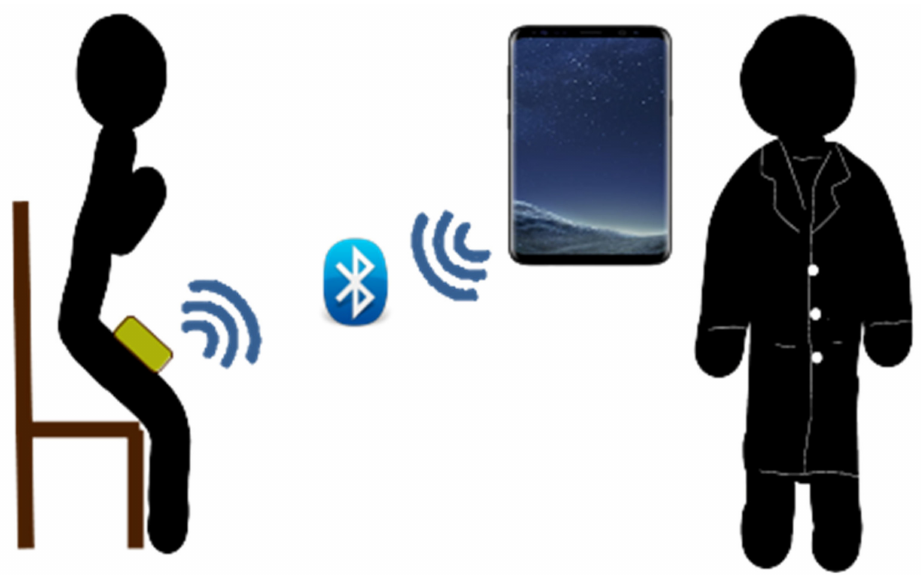
Figure 1. Depiction of the overall experimental setup: The subject stands up from and sits down on a regular rigid chair with the sensing device on one of his thighs; the sensing device is paired with a tablet via Bluetooth; a member of the research team uses the app on board the tablet device to switch the sensor into either calibration or measurement modes, and to visualize the sensor automatic count once the 30-s chair stand test (CST) is over.